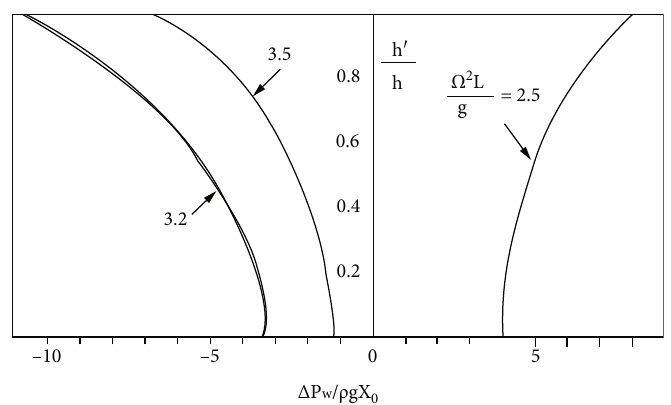
Figure 2: Under lateral excitation, a rectangular tank ’ s wall pressure distribution corresponds to the fi rst antisymmetric mode [32].